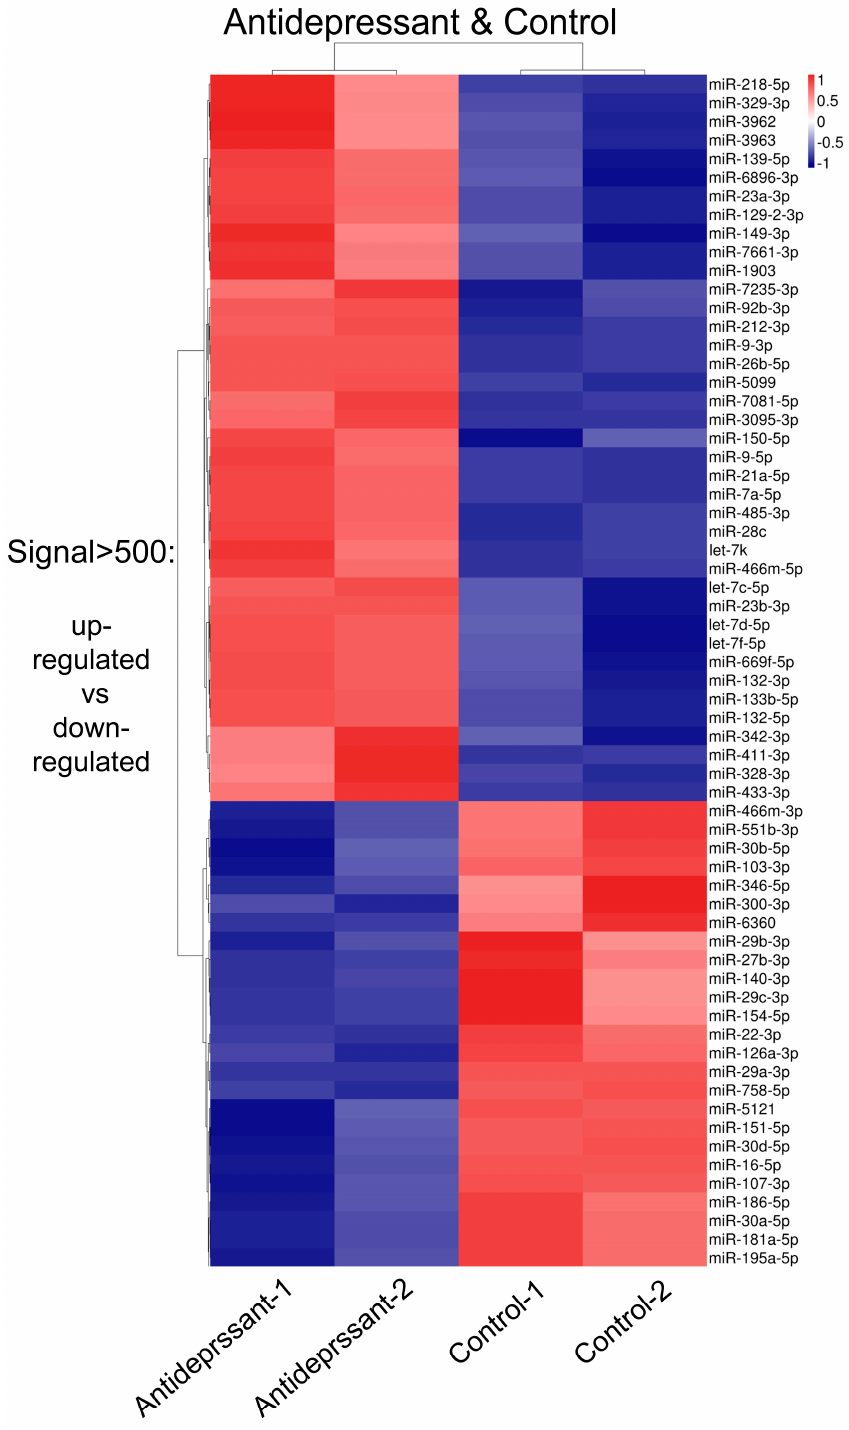
Figure 2. The heatmap of normalized expression of miRNAs in hippocampi of antidepressant administration and control mice to distinguish the difference of expression. The heatmap was drawn with normalized expression ((x − min)/(max − min)) of each miRNA. The “x” means the expression of each miRNA, “min” means the lowest expressed miRNA and “max” means the highest expressed miRNA. Blue, white and red indicate relatively low, middle and high expression of miRNAs, respectively.